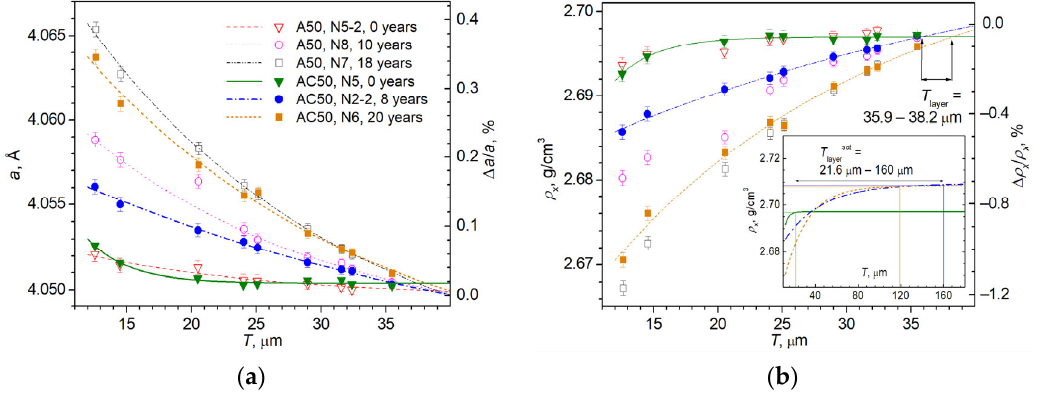
Figure 15. Distribution of ( a ) the cubic unit cell parameter a ( T ) and ( b ) the XRD mass density ρ x ( T ) of the wire Al material along the depth T from the surface of the A50 and AC50 wires. Samples are numbered according to Table 2 and their service lifetimes are shown in ( a ). The symbols for ( b ) are the same as shown in ( a ). At the right sides of ( a , b ), the axes are shown corresponding, respectively, to the lattice defect Δ a / a and the density defect Δ ρ x / ρ x , which are estimated with respect to the bulk of the non ‐ exploited sample of A50 type (N5 ‐ 2, 0 years of operation). The approximation lines in ( a , b ) are drawn according to the exponential decay law. In ( b ), the thicknesses T layer of the NSDL are estimated for AC50 wires from the intersection of the distribution curves for AC50 samples of different non ‐ zero service lives with the curve corresponding to a non ‐ used sample (N5 ‐ 2, service life of 0 years). The inset in ( b ) presents the extrapolations of the distribution curves of AC50 wires to depths of 200 μ m from the surface for samples. The shown estimates of the total thickness T layersat of the NSDL for wires are obtained from the intersection with tangents drawn at the points when the distribution curves reach a plateau (when ρ x reaches the value ρ xsat = 99.99% of the density estimated from the distribution curve at a depth of 200 μ m).